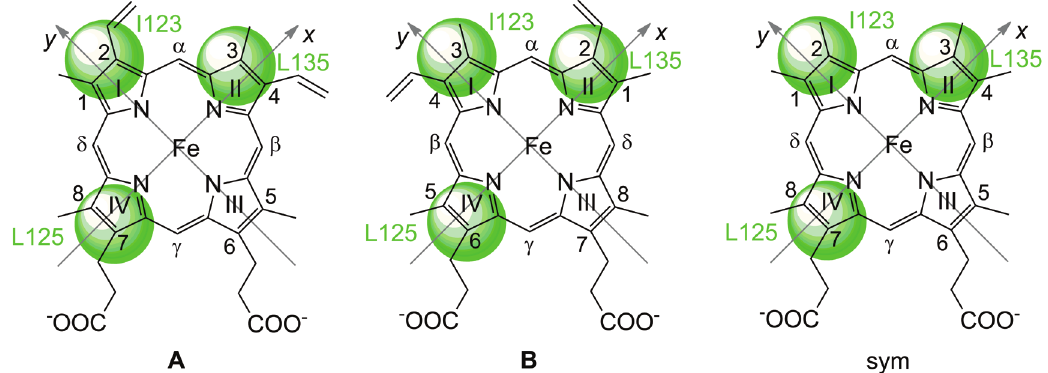
Figure 3. Heme b nomenclature and heme orientation inside the pocket of NP7. The heme pocket of NP7 is indicated by the three green circles corresponding to the position of the three aliphatic side-chains pointing from the top of the distal pocket onto the heme plane. The two possible heme orientations are indicated as A and B